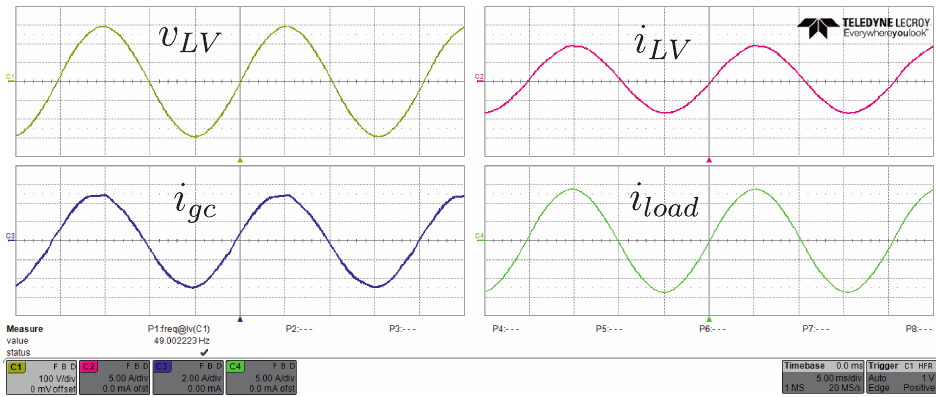
Figure 11. Steady-state during the overload controller operations (Figure9, green box): ST voltage (yellow line, 100V/div), ST current (magenta line, 5A/div), DG current (blue line, 2A/div), load current (green line,